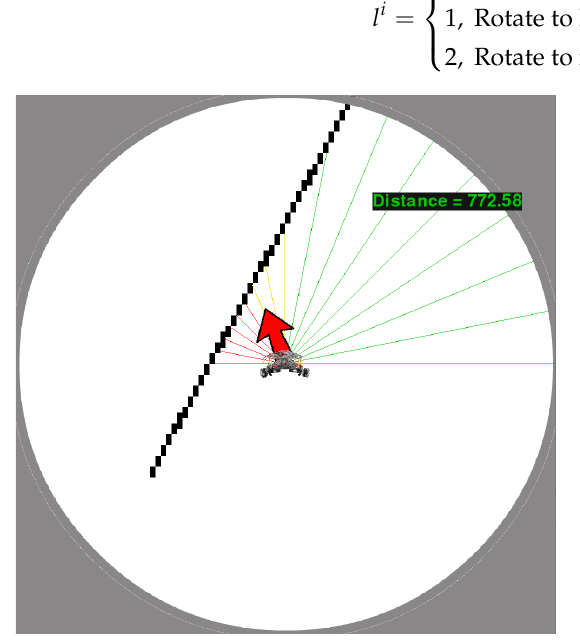
Figure 4. A straightforward example of user data collection.